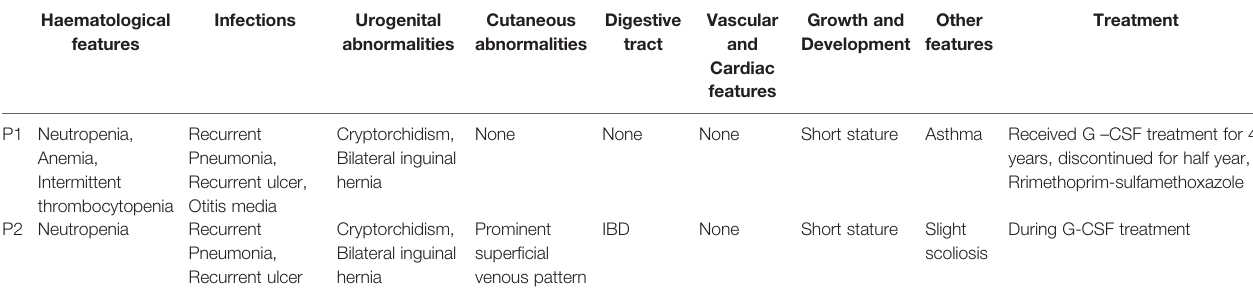
TABLE 1 | Clinical characteristics of patients with G6PC3